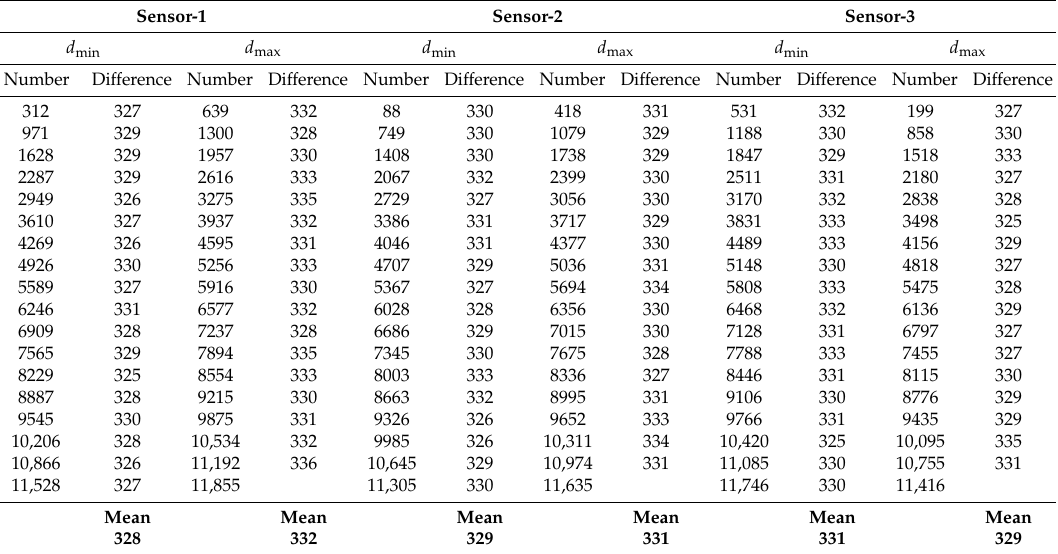
Table 2. Sensor extreme point sequence